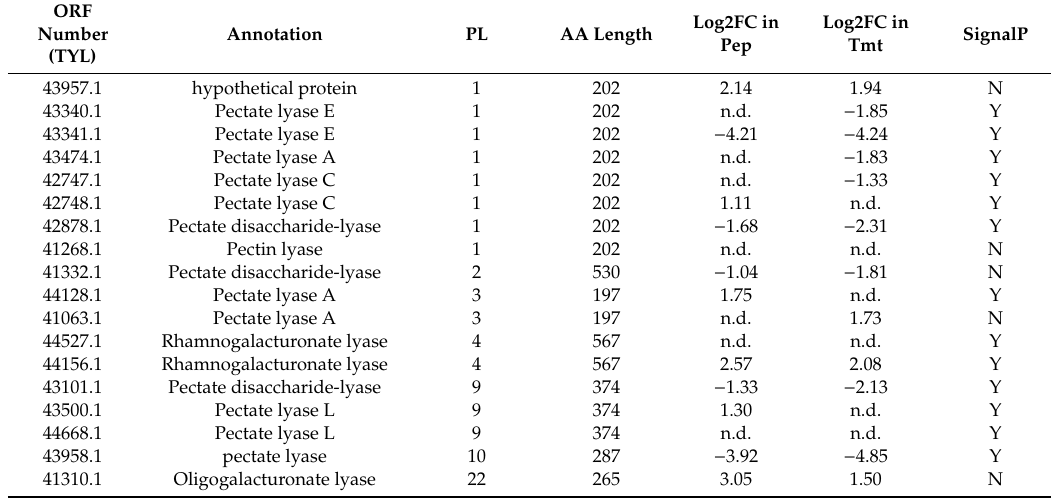
Table 3. Pectin degradation relevant polysaccharide lyases (PL) enzymes and its transcriptome profile in pepper or tomato stalk compared to Luria Bertani (LB)